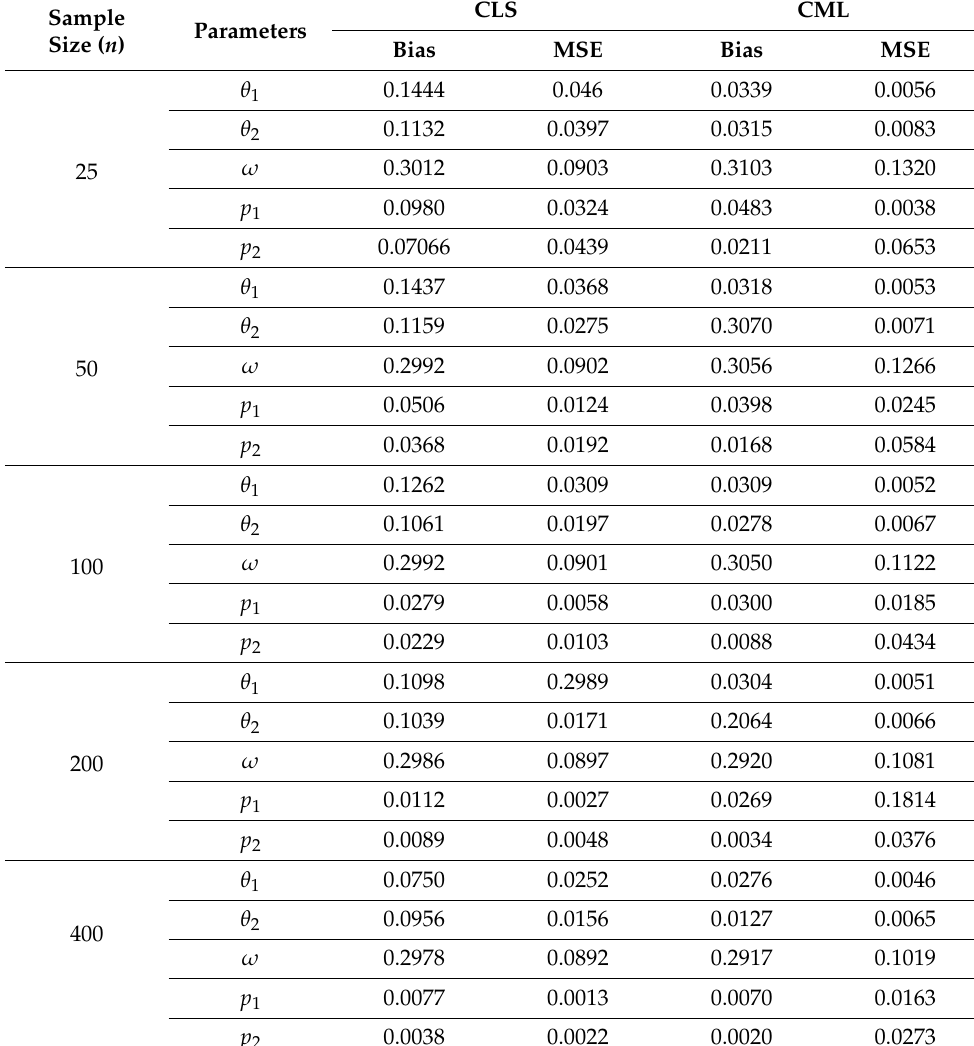
Table 6. Simulation results for the BINAR(1)BP2S-L(II) process for the set of parameter